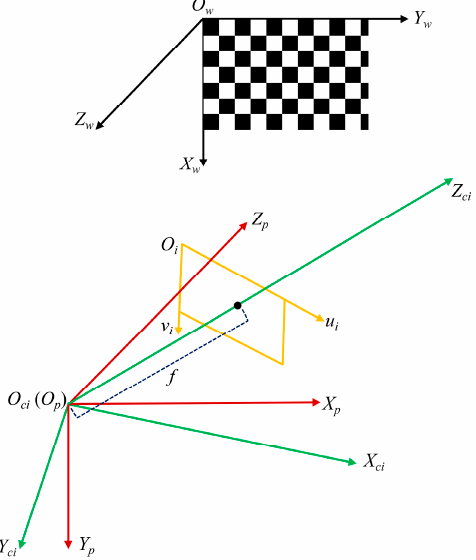
Figure 2. Schematic diagram of the coordinate systems.